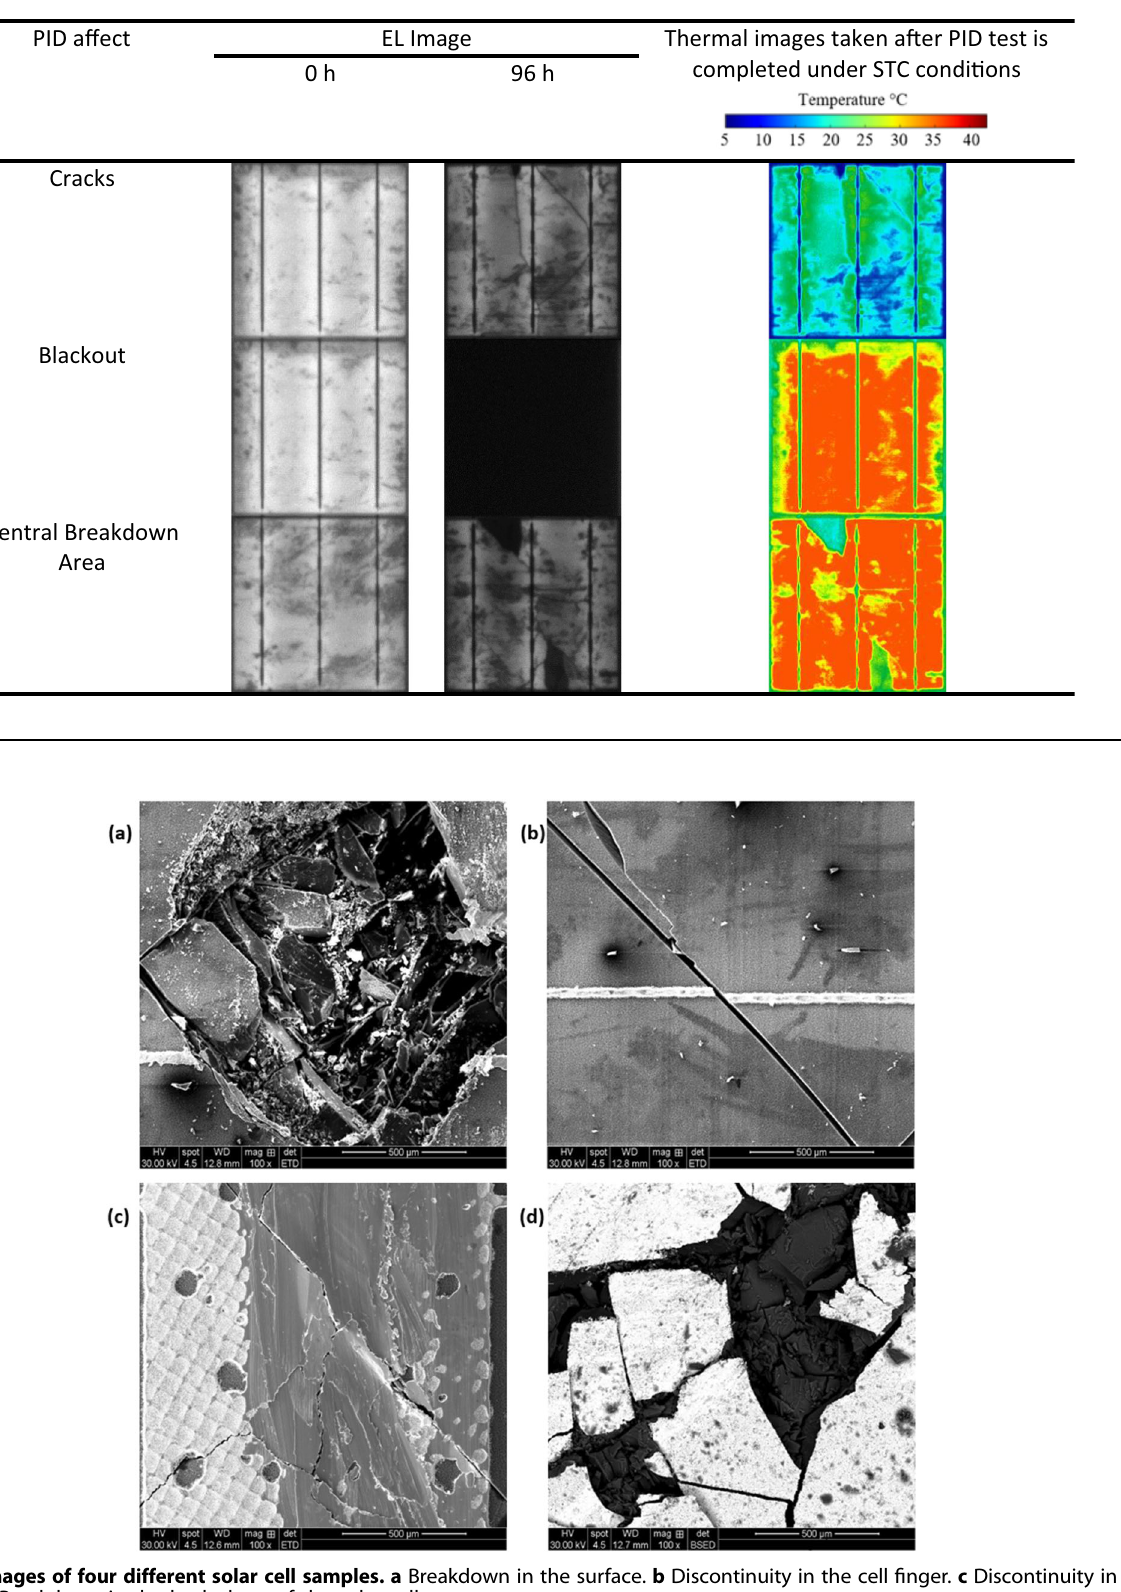
Table 1. Cell-level PID affect.